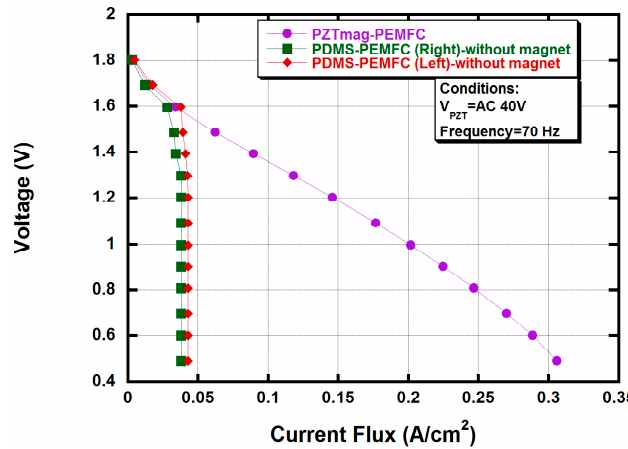
Figure 9. PDMS without using the magnet with a bi-cell PEMFC.